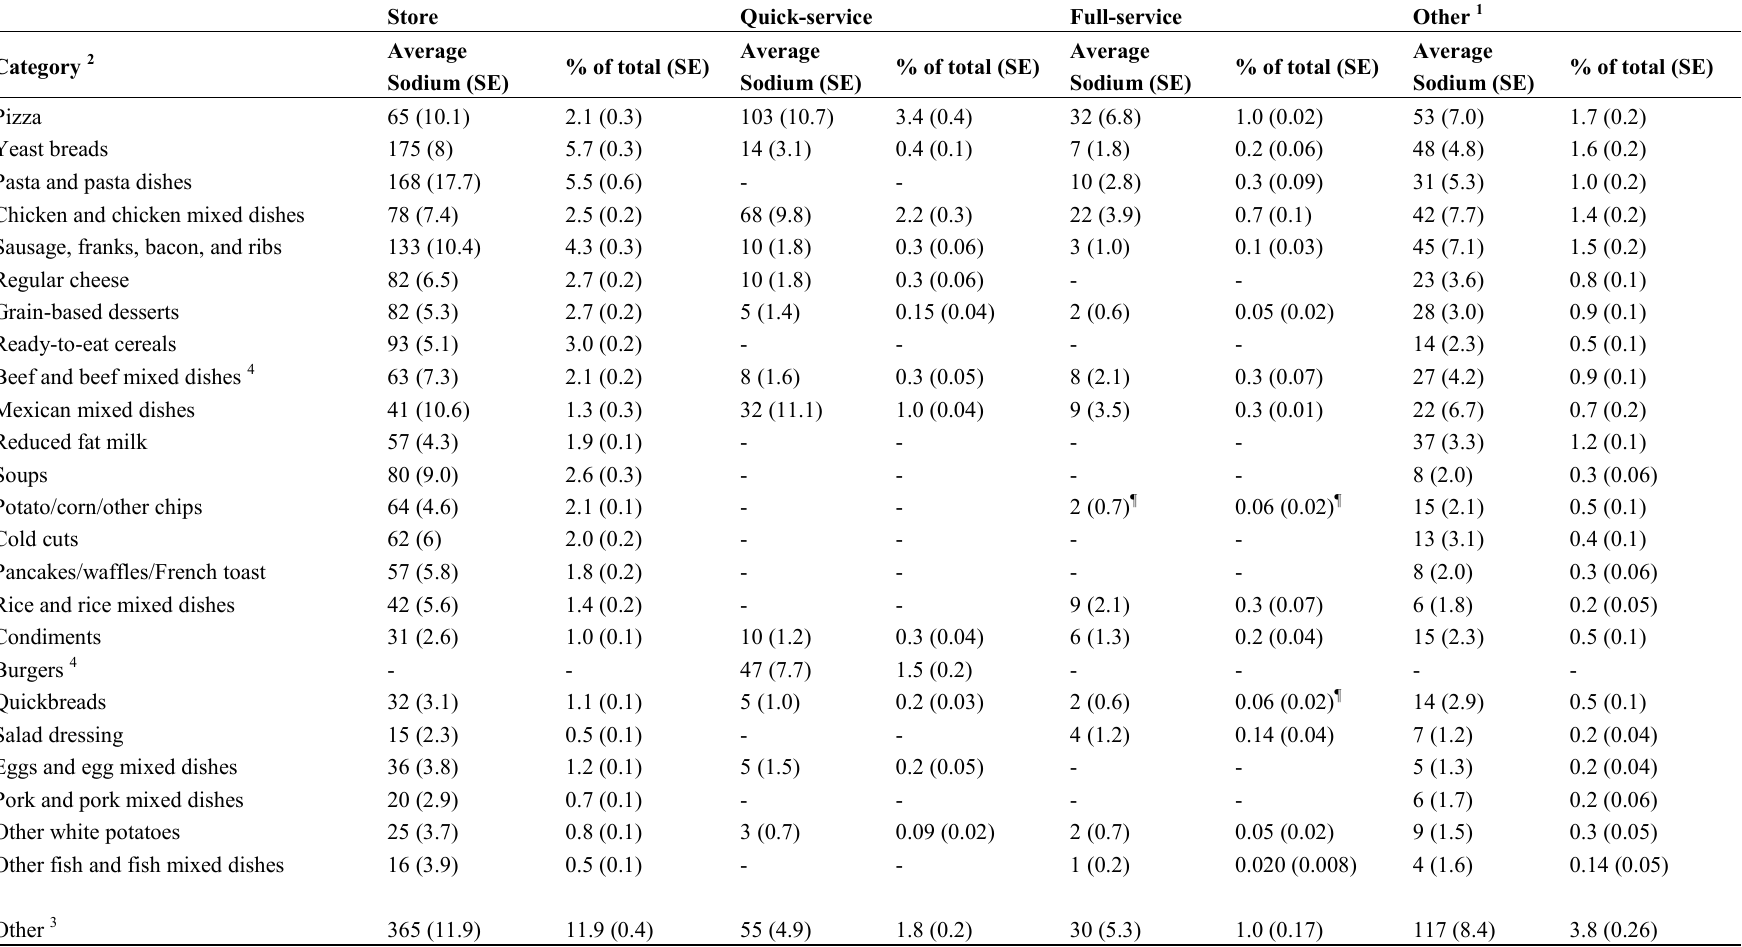
Table 2. Contribution to total sodium intakes from specific food sources by purchase location for children (6–11 years), NHANES